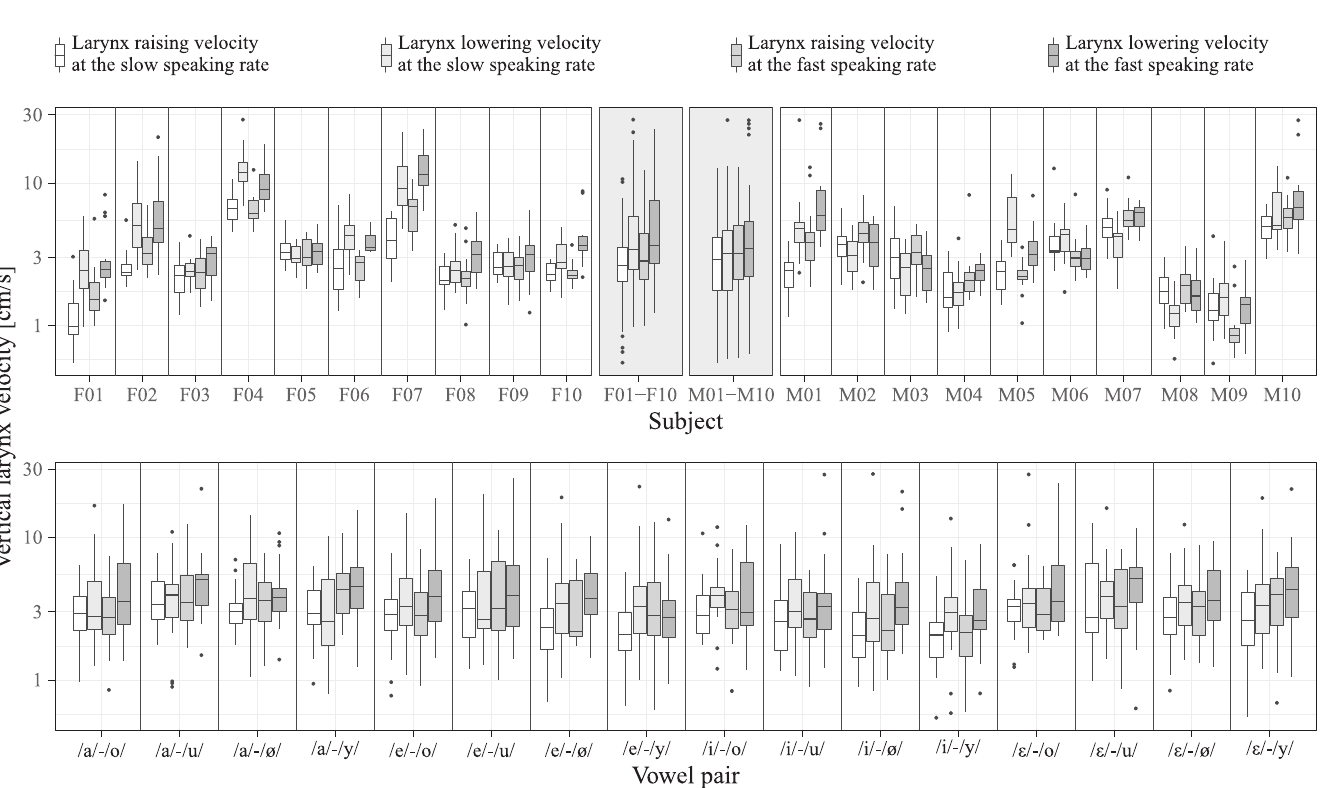
Fig 3. Overview of the data. For each woman F01, F02, ... , F10 (top left), for each man M01, M02, ... , M10 (top right), and for each vowel pair (bottom), respectively, the first boxplot shows the larynx raising velocities at the slow speaking rate, the second boxplot shows the larynx lowering velocities at the slow speaking rate, the third boxplot shows the larynx raising velocities at the fast speaking rate, and the fourth boxplot shows the larynx lowering velocities at the fast speaking rate, where the brightness decreases from the first to the fourth boxplot. For the visualization, the vertical larynx velocities for each subject were pooled across all vowel pairs, the vertical larynx velocities for each vowel pair were pooled across all subjects. Additionally, in order to highlight sex-dependent effects, the vertical larynx velocities for each sex were pooled across all subjects of that sex and across all vowel pairs (top middle, gray background).